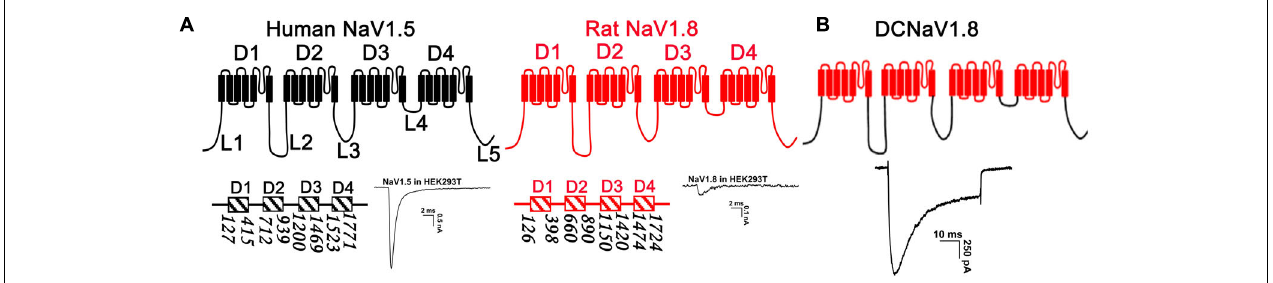
FIGURE 1 | Strategy for NaV chimeras construction. (A) The topological structure of NaV1.5 and NaV1.8, the numbers indicated the border of the transmembrane domains, the representative current traces showed the NaV1.5 and NaV1.8 expressions in HEK293T cells. (B) Replacing the transmembrane domains of NaV1.5 with those of NaV1.8 constructed a chimeric channel (DCNaV1.8) functionally expressed in HEK293T cells. Currents were elicited by depolarizing to +10 mV from holding potential of –100